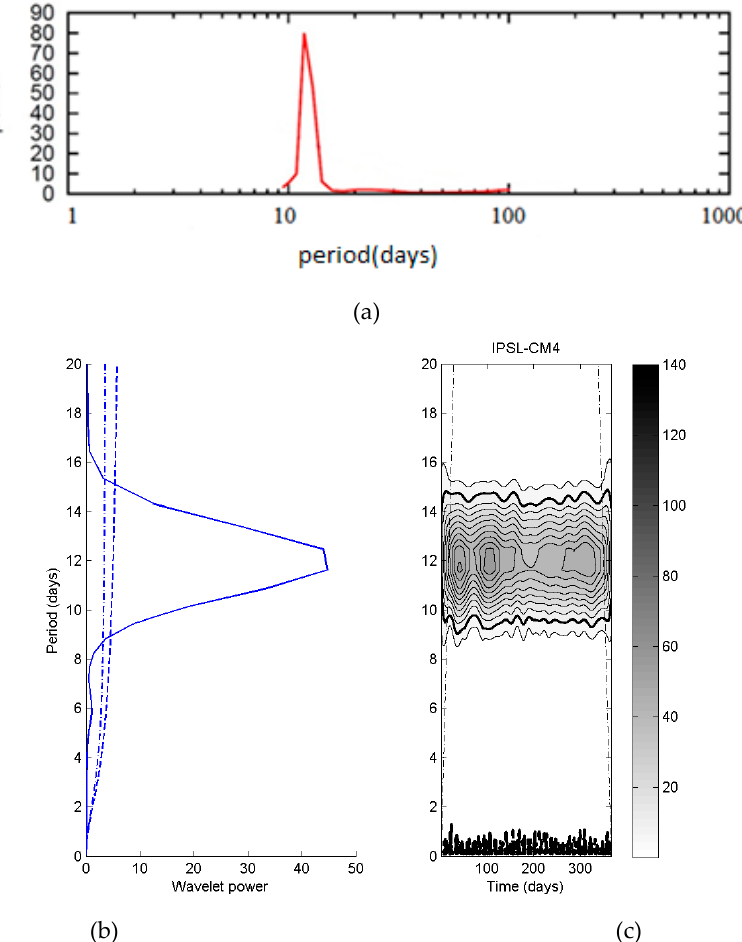
Figure 2. The Integrated Regional Enstrophy (IE) (× 10 − 6 m 2 s − 2 —ordinate) diagnostic derived from the Northern Hemisphere 500 hPa heights for the ( a ) band passed (5–40 day) Fast Fourier Transform (FFT) power spectra (ordinate) versus spectral period (days—abscissa) (top), and ( b ), and ( c ) the wavelet power spectra (time period is days) (bottom). In ( b ) and (c) the dashed lines represent statistical significance at 90 and 95%, and regions where edge effects become important [47], respectively. Only peaks with statistically significant power are shown in (c).